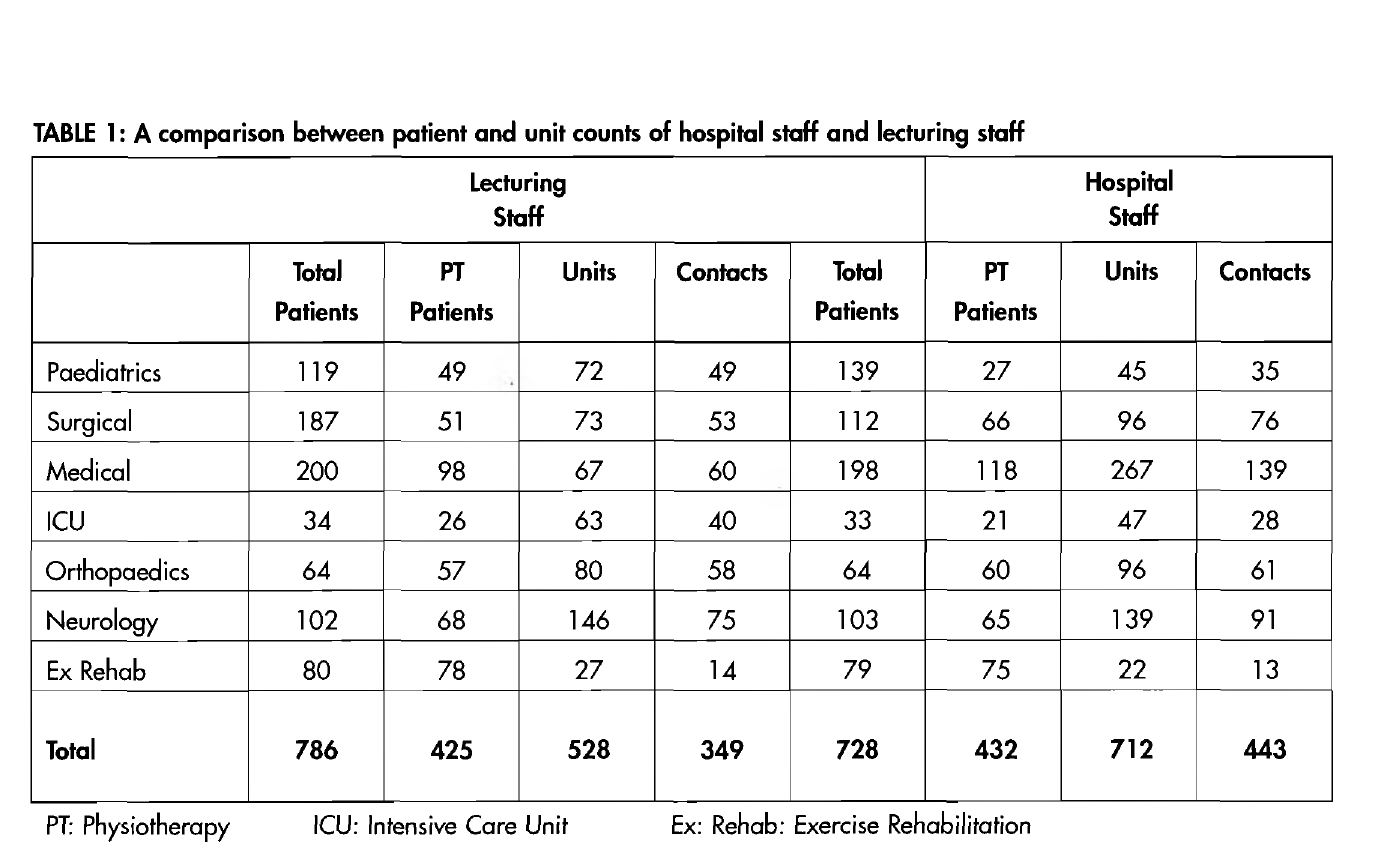
TABLE 1: A comparison between patient and unit counts of hospital staff and lecturing